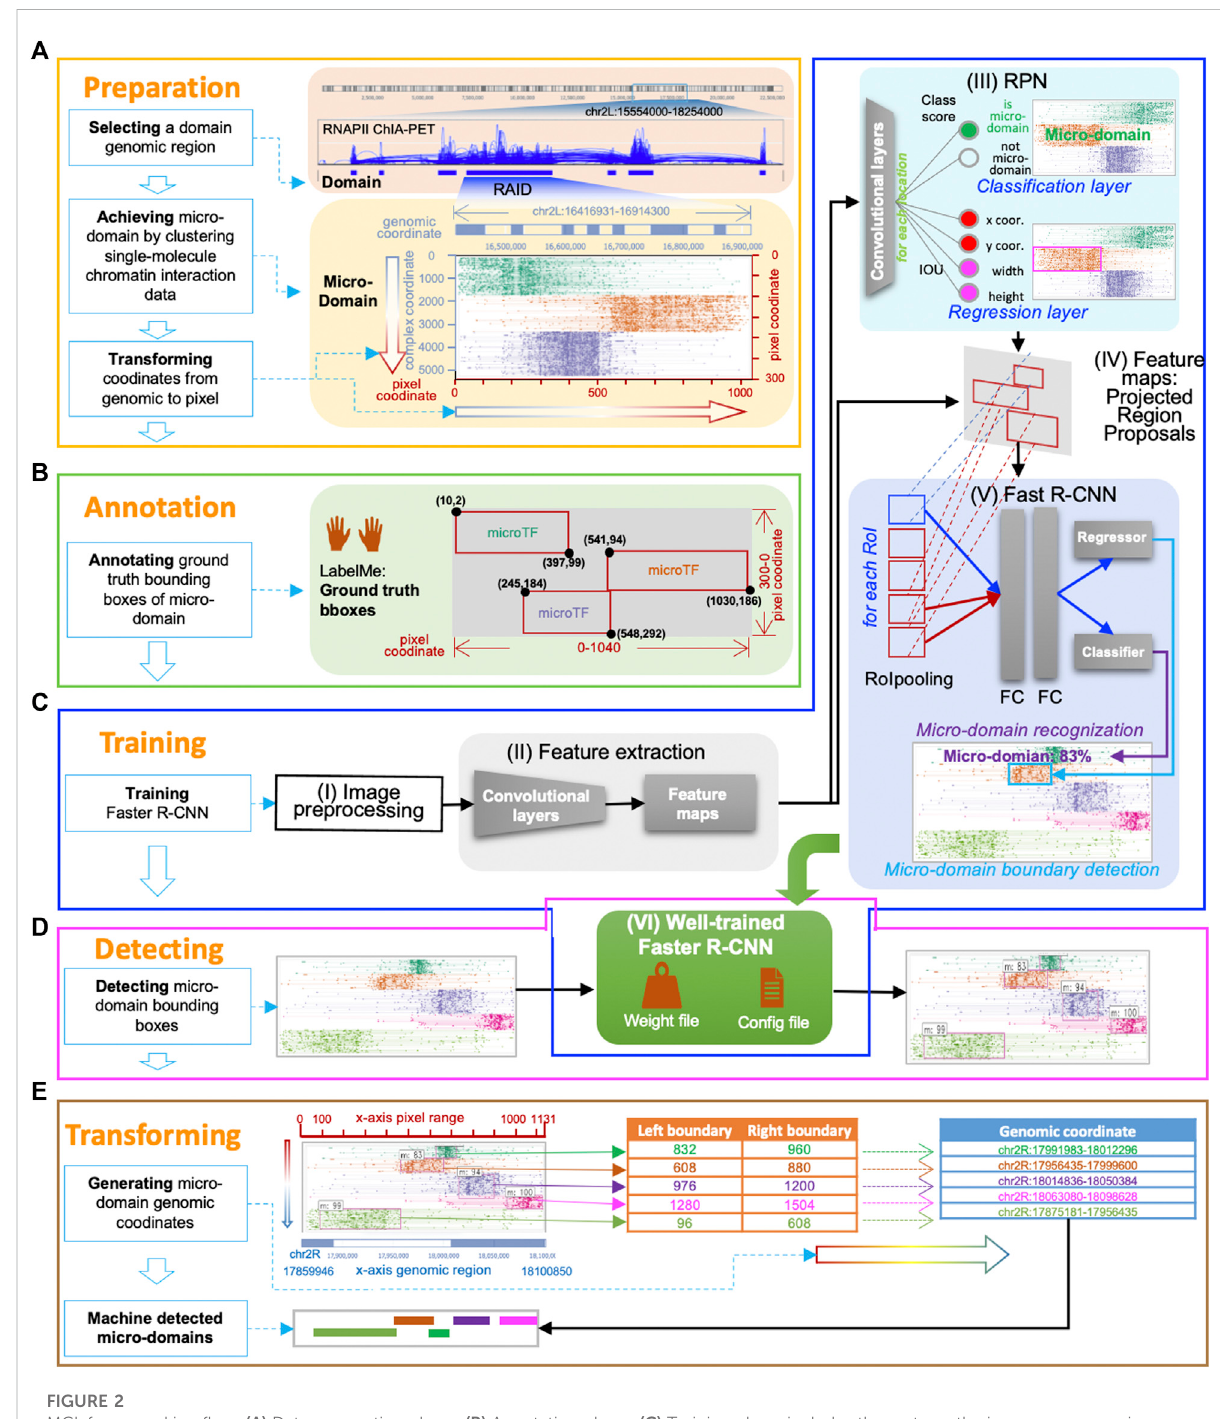
FIGURE 2 MCI-frcnn working fl ow. (A) Data preparation phase. (B) Annotation phase. (C) Training phase includes these steps: the image preprocessing step (I), the feature extraction step (II), the RPN training step (III), the Regions of Interest (RoIs) projection step (IV), the Fast R-CNN detector training step (V), and the fi netuned Faster R-CNN step (VI). (D) Detecting phase. (E) Micro-domain genomic coordinates transforming